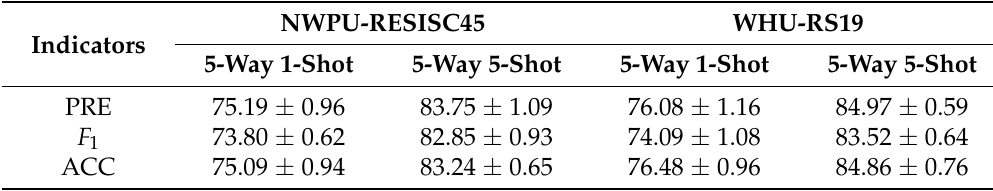
Table 5. Classification results of our proposed model on two datasets.